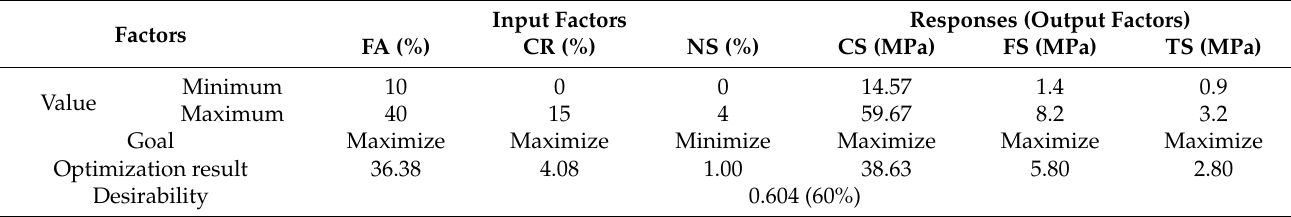
Table 6. Optimization goals and results.